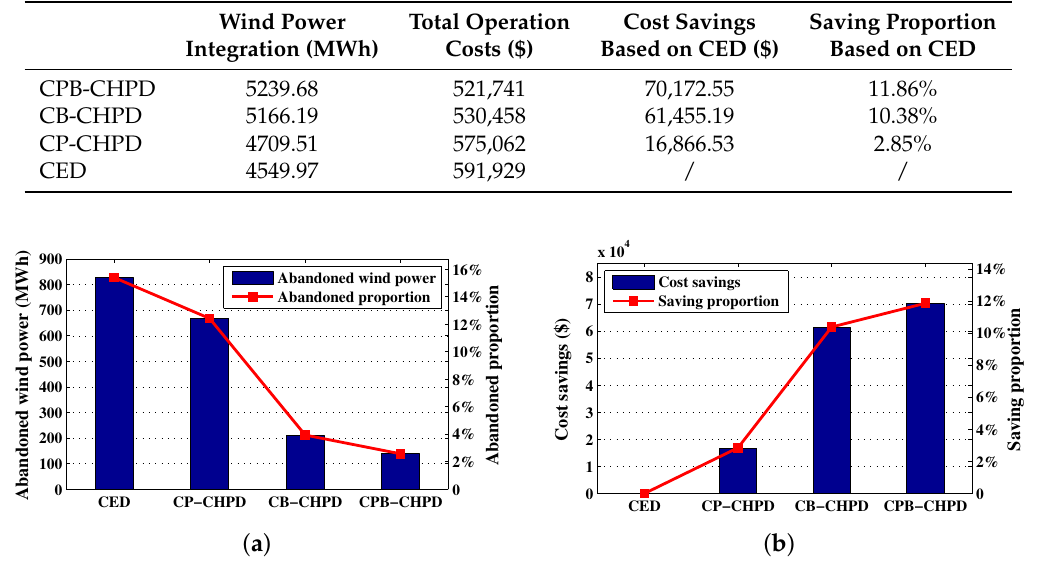
Figure 10. Optimal result comparison of the four dispatch models, including the CPB-CHPD, CB-CHPD, CP-CHPD and CED models: ( a ) abandoned wind power; ( b ) operation cost